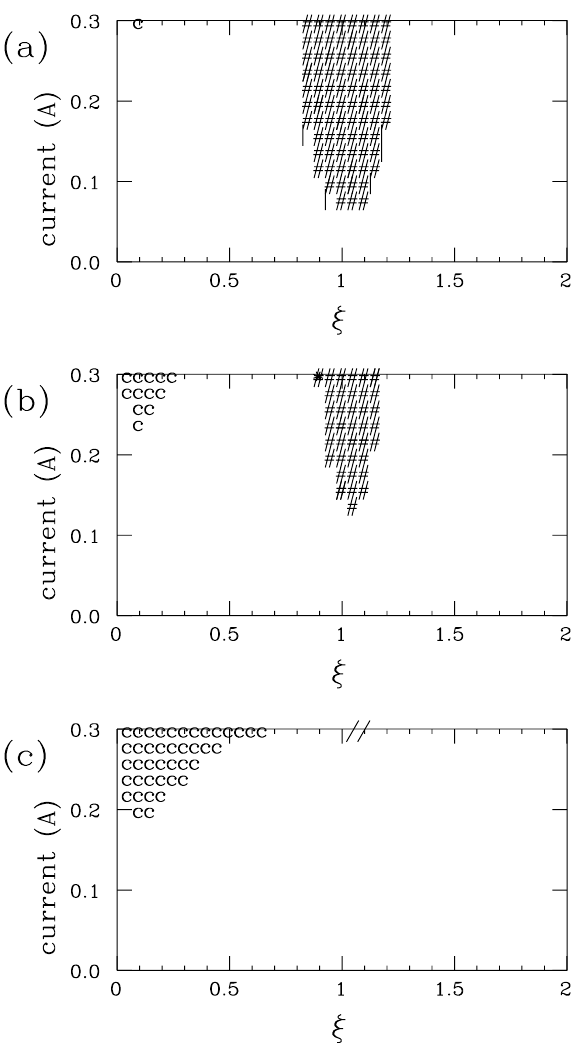
FIG. 12. Instability predictions which include dipole- quadrupole mode coupling for active Landau-cavity operation with the LF20 lattice for three values of the Landau-cavity ef- fective rf coupling ( b 2 ). Vertical line: coupled-dipole Robinson instability; *: coupled-quadrupole Robinson instability; #: fast mode-coupling Robinson instability; /: equilibrium phase instability; c: coupled-bunch instability with longitudinal